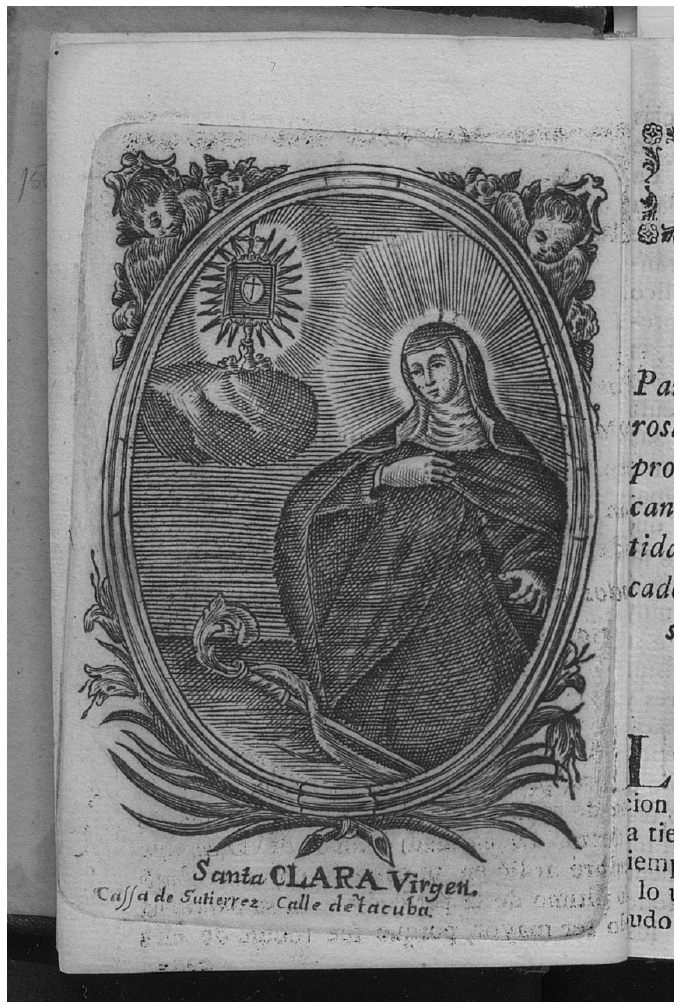
Figure 2. Augustina Meza, attributed, Santa Clara , ca. 1770. Engraving. Photograph used with permission of the Cushing Memorial Library and Archives, Texas A&M University.